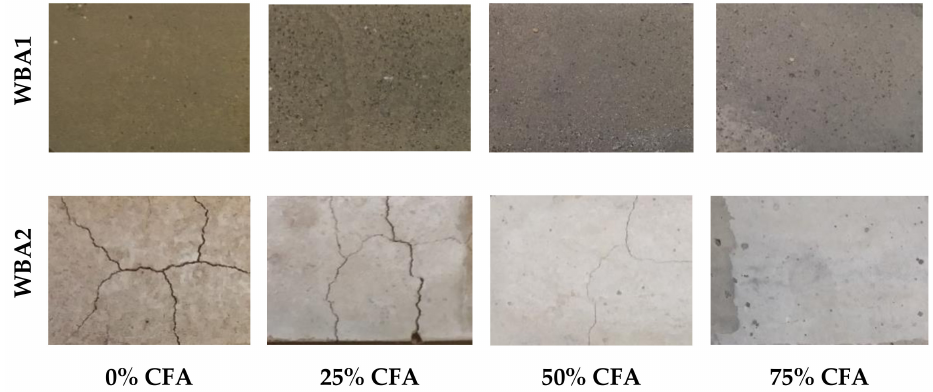
Figure 13. Surface appearance of samples with WBA1 and WBA2 after 28